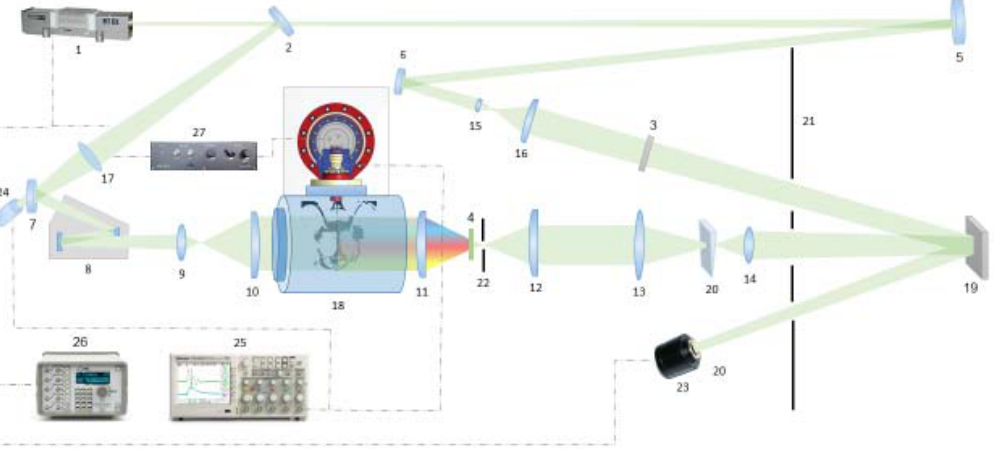
Figure 2. Scheme of optical diagnostics: 1–Solar Nd:YAG LQ115 laser (532 nm), 2–splitter, 3–neutral ‐ density filter, 4–interference filter ( λ = 532 nm, Δλ = 10 nm), 5, 6, 7–mirrors, 8–laser beam expander, 9–17–lenses, 18–discharge chamber, 19–screen, 20–quartz wedge, 21–light blocking screen, 22–diaphragm of 1.2 mm, 23–Videoscan VS ‐ 285C CCD camera, 24–photodiode, 25–Tektronix TDS2024b oscilloscope, 26–BNC575 pulse/delay generator, 27–thyratron driver PB ‐ 3DV.